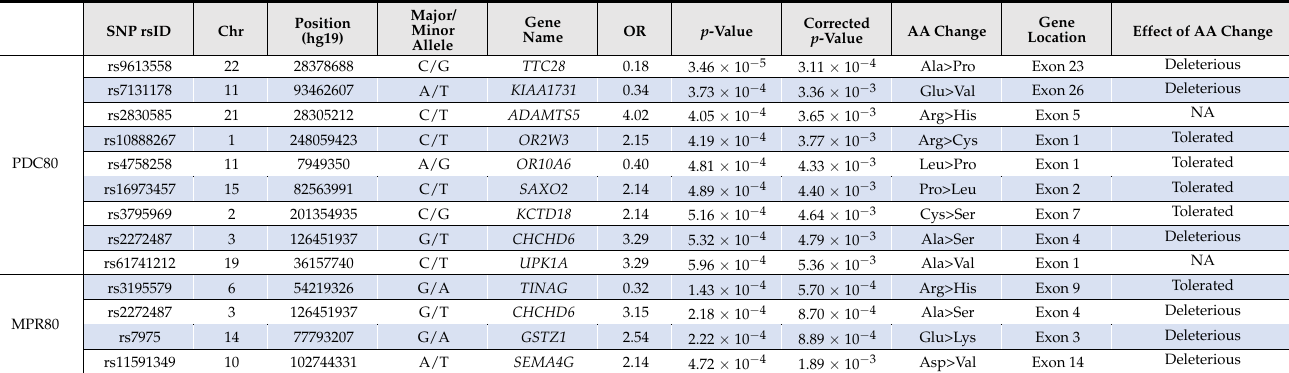
Table 3. Significant coding variants in PDC80 and MPR80.